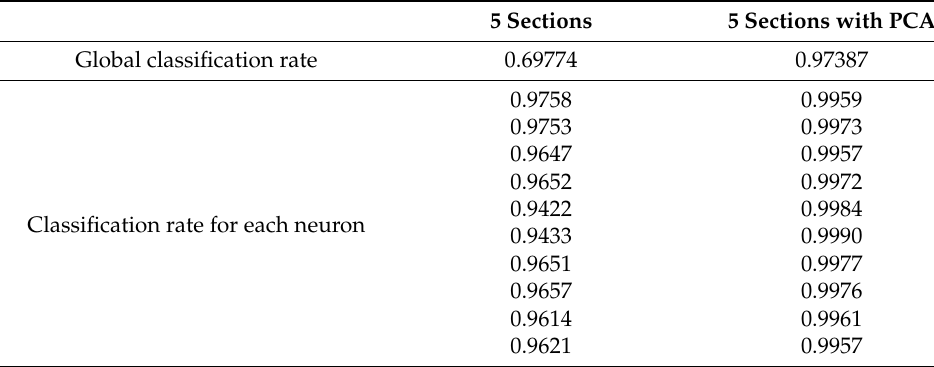
Table 9. Summary of the classification results obtained for five cable